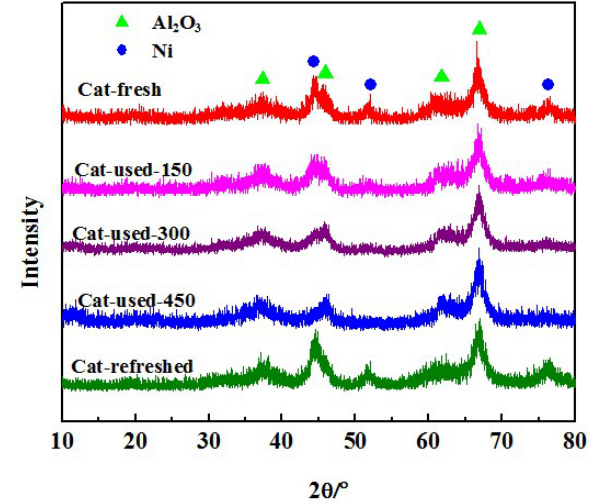
ff raction patterns of Figure 2. X-Ray diffraction patterns of catalysts. Figure 2. X-Ray di Figure 2. X-Ray diffraction patterns of catalysts.